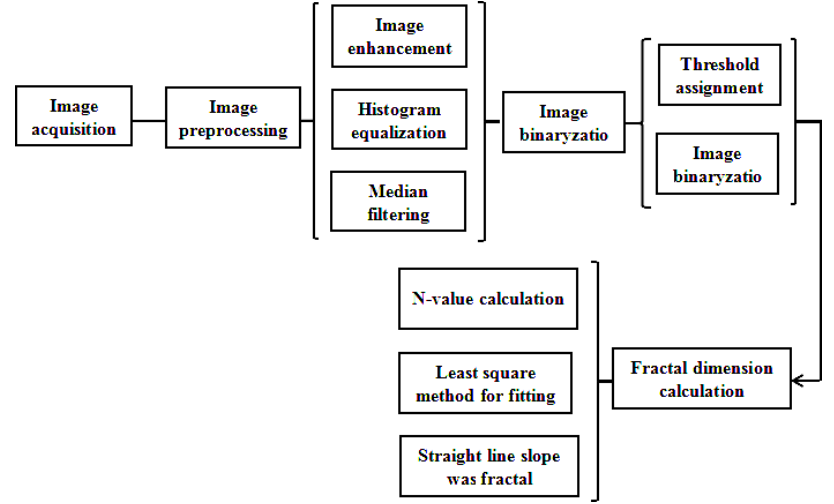
Figure A1. Calculation process for obtaining the fractal dimension.